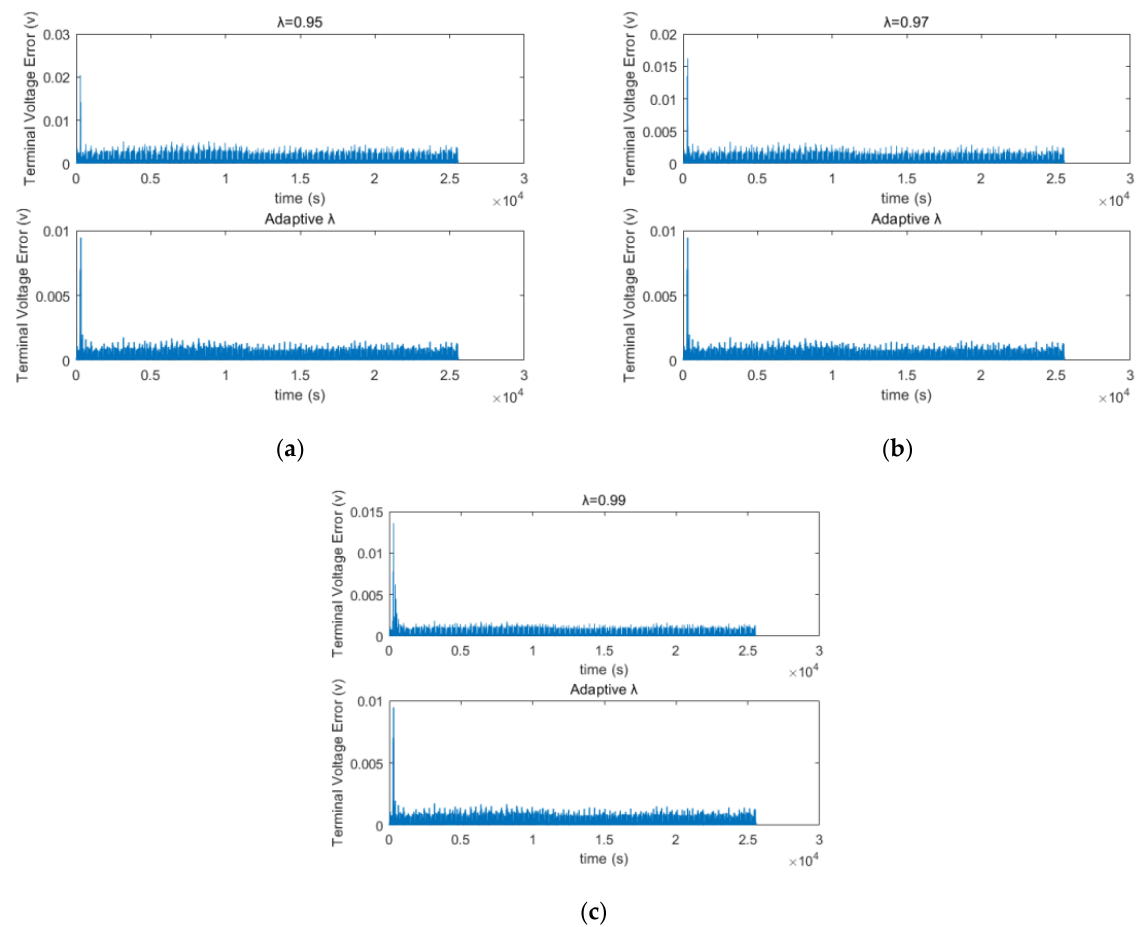
Figure 6. Terminal voltage error comparison: ( a ) λ = 0.95 vs. adaptive λ , ( b ) λ = 0.97 vs. adaptive λ, ( c ) λ = 0.99 vs. adaptive λ .